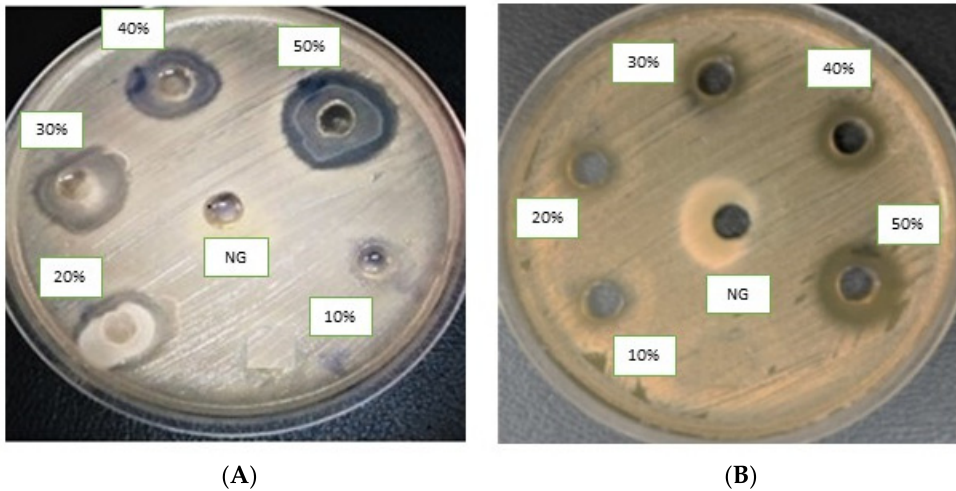
Figure 3. Agar well diffusion assay of antibacterial compounds against ESBL-producing E. coli ST131. Compounds ( 4a ) ( A ) and ( 4c ) ( B ). DMSO is a negative control. Table 3. MIC and MBC of compounds ( 4a – h ) against ESBL-producing E. coli ST131. Compound No.